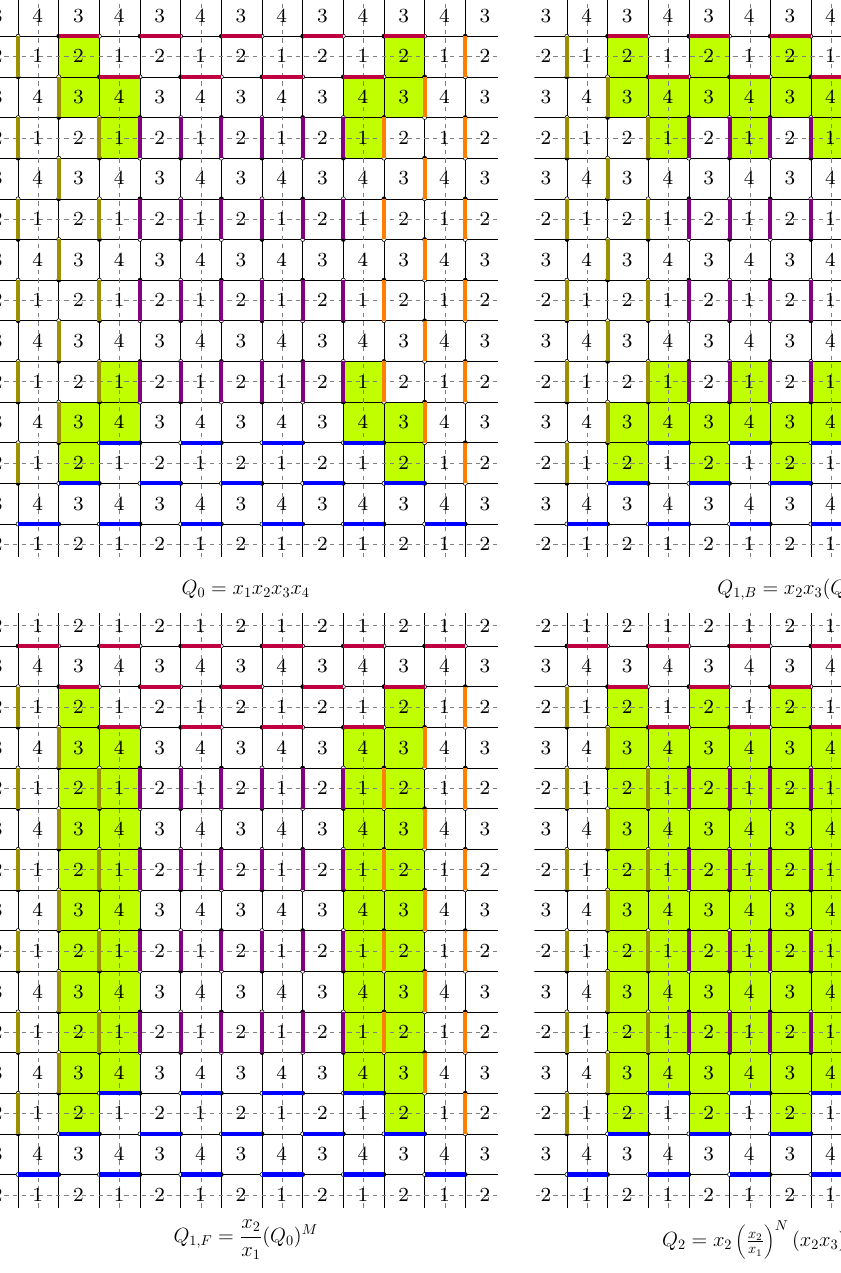
Figure 6 . Toda bipartite lattices with “empty room” configuration D the rotations corresponding to addition of boxes weighted by Q 0 , Q 1 ,B , Q 1 ,F , Q 2 are highlighted by lime